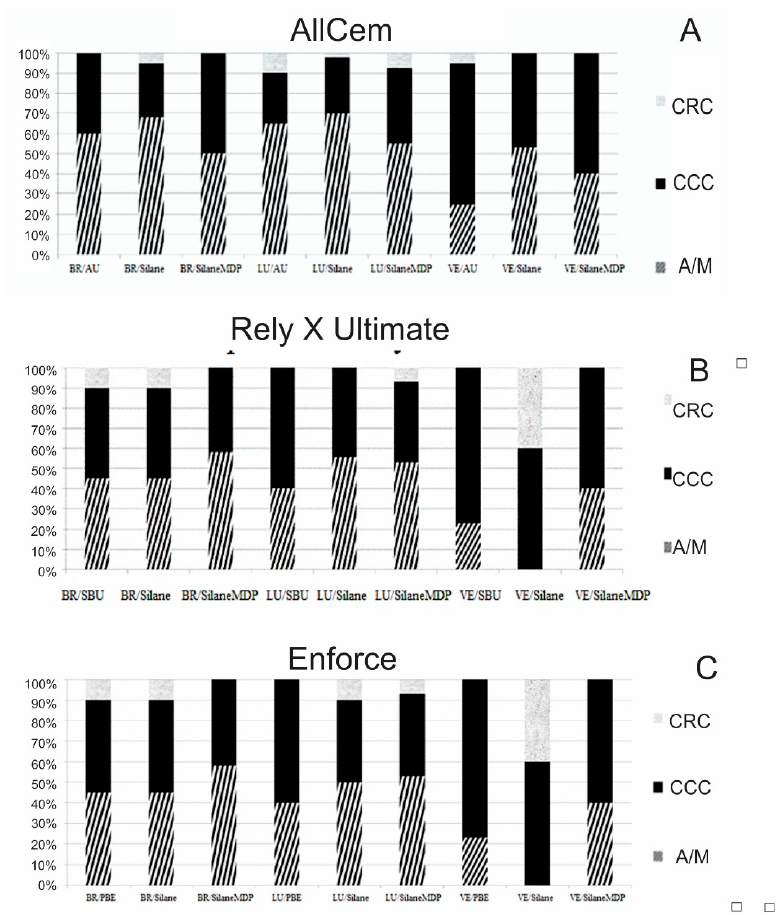
Figure 3. Distribution of failure pattern in the experimental groups using AllCem ( A ), Rely X Ulti- mate ( B ), and Enforce ( C ). ( B ), and Enforce ( C